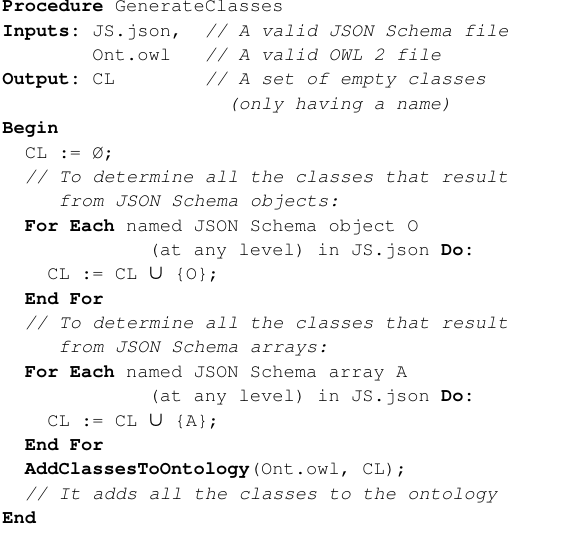
Fig. 3 Algorithm of the “GenerateClasses” procedure.